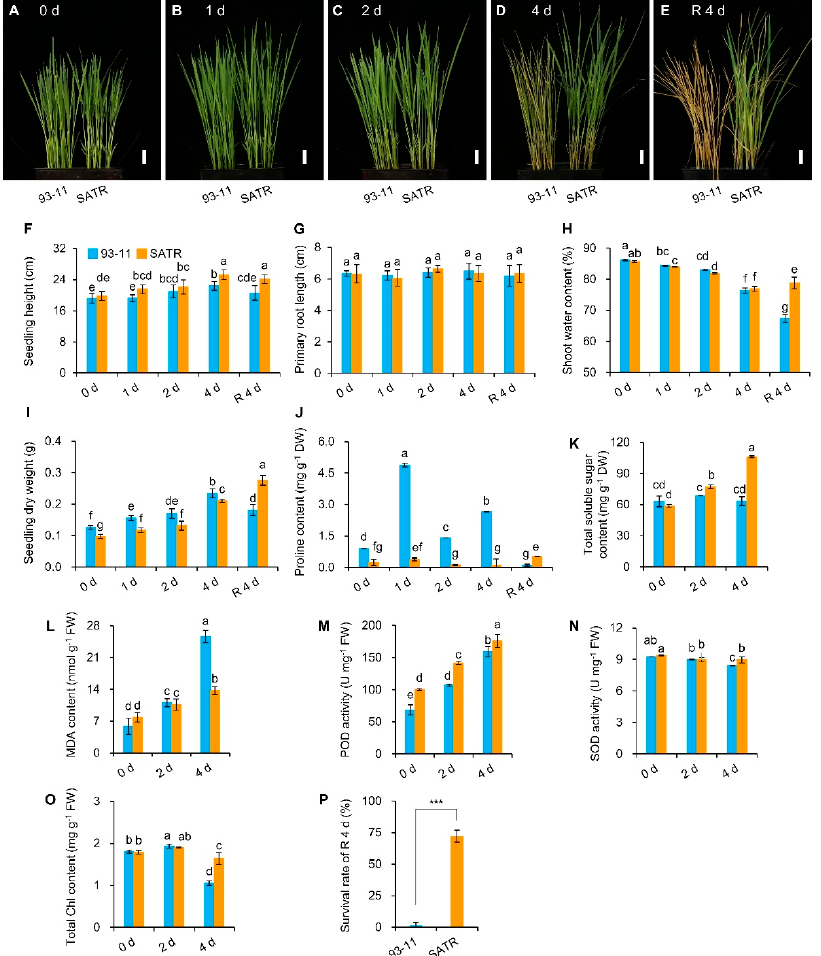
Figure 1. Phenotypic and physio-biochemical analysis in SATR and 93-11 seedlings under SSAS. ( A – E ) Seedlings of 93-11 and SATR before SSAS ( A ), on the 1st ( B ), 2nd ( C ) and 4th ( D ) days after SSAS treatment, and 4 days of recovery ( E ), respectively. ( F – P ) Comparisons of phenotypic and physio-biochemical indexes, including seedling height ( F ), primary root length ( G ), shoot water content ( H ), seedling dry weight ( I ), as well as proline content ( J ), total soluble sugar content ( K ), malonaldehyde (MDA) content ( L ), peroxidase (POD) activity ( M ), superoxide dismutase (SOD) activity ( N ) and total chlorophyll content ( O ) of shoots in SATR and 93-11 before SSAS, under SSAS and recovery after SSAS, respectively. ( P ) Comparison of the survival rate between SATR and 93-11 seedlings after 4 days of recovery. d, day or days; R 4 d, after 4 days of recovery. Bar = 2 cm ( A – E ). The blue and orange bars indicate 93-11 and SATR, respectively ( F – P ). Data is given as mean ± SD, which was obtained from three independent biological replicates ( F – P ), and each replicate con- tained 5 seedlings ( F – O ) or 24 seedlings ( P ). Chl, chlorophyll. The different letter on the bars in each bar chart indicates the significant difference at p < 0.05 level obtained by one-way analysis of vari- ance (ANOVA) and Duncan’s new multiple range test ( F – O ). *** p < 0.001, Student’s t -test ( P ).